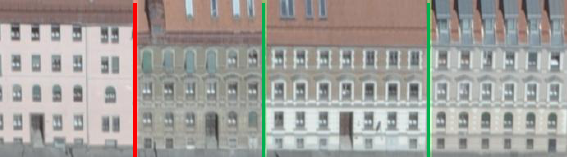
Figure 2. Result of façade separation for one building block from the test area. As one can notice all buildings were separated correctly. Separations marked in red correspond to splits based on building height, while those marked in green are the result of repetitive pattern analysis.